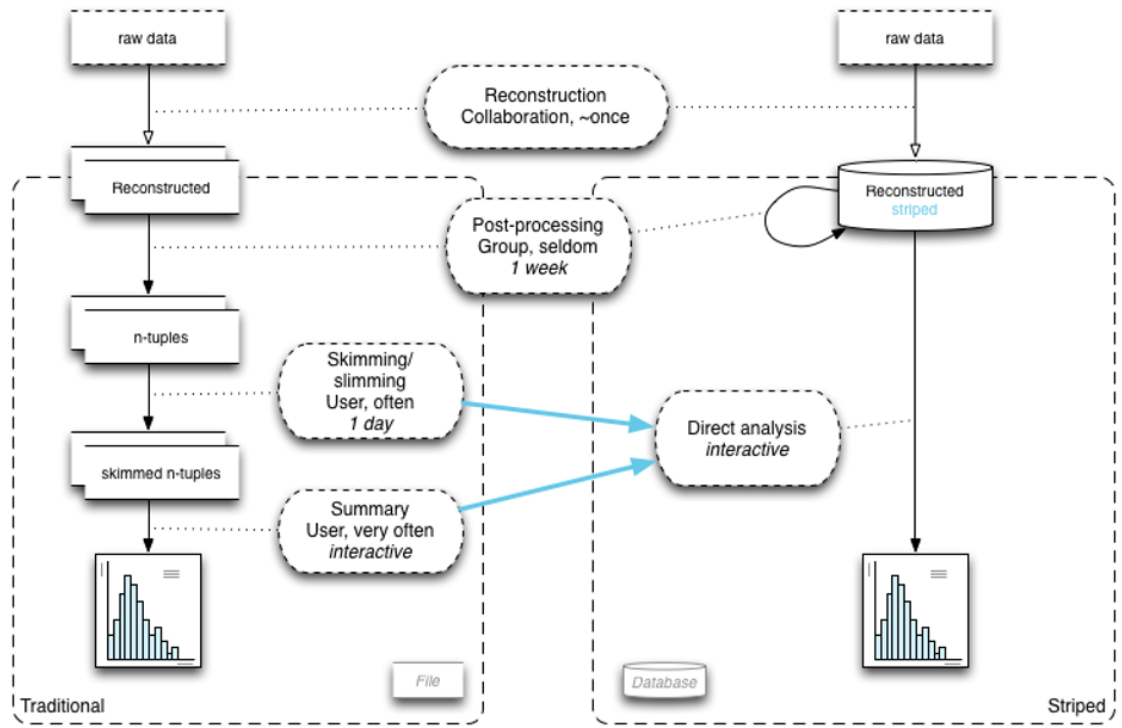
Figure 1. Data analysis